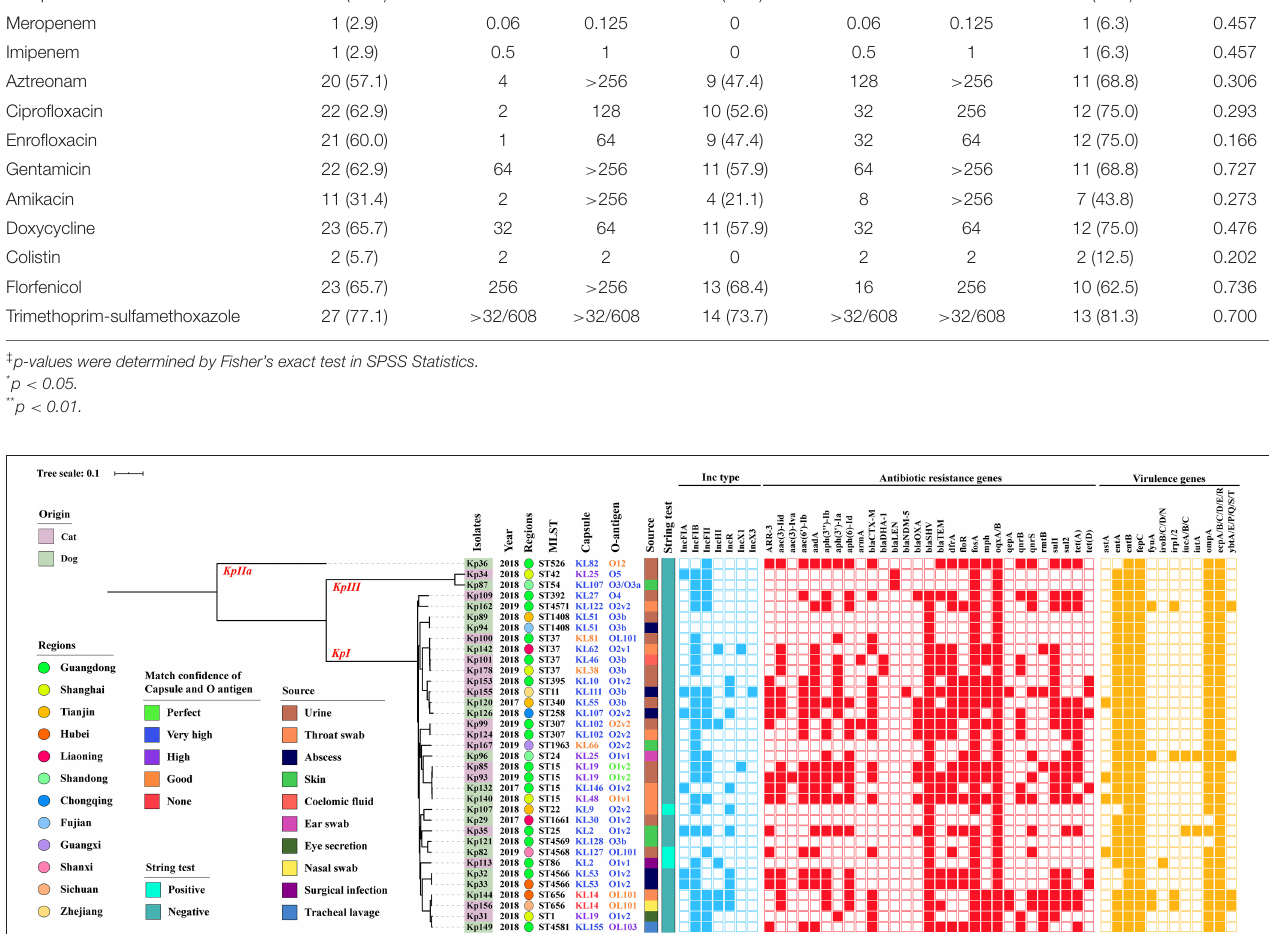
and monitoring, we obtained seven Inc-type plasmids, which were dominant by IncFIB (77.1%, n = 27/35), IncFII (54.3%, n = 19/35), IncR (28.6%, n = 10/35), followed by IncFIA (20%, n = 7/35), IncHI (14.3%, n = 5/35), IncX1 (5.7%, n